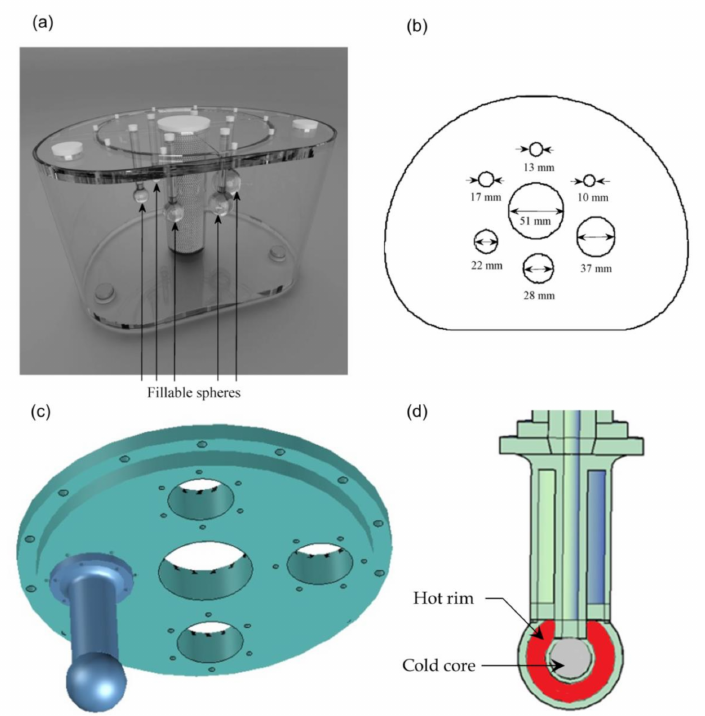
Figure 1. ( a ) Torso NEMA phantom for PET with six fillable spheres and a cold insert in the middle; ( b ) the diameter of each of the six spheres; ( c ) CAD drawing of the lead with the heterogeneous insert; and ( d ) CAD drawing showing the two spheres to create a hot rim and cold core. The diameter of the inner sphere is 13 mm. The outer sphere diameters are 25 and 33 mm for two separate